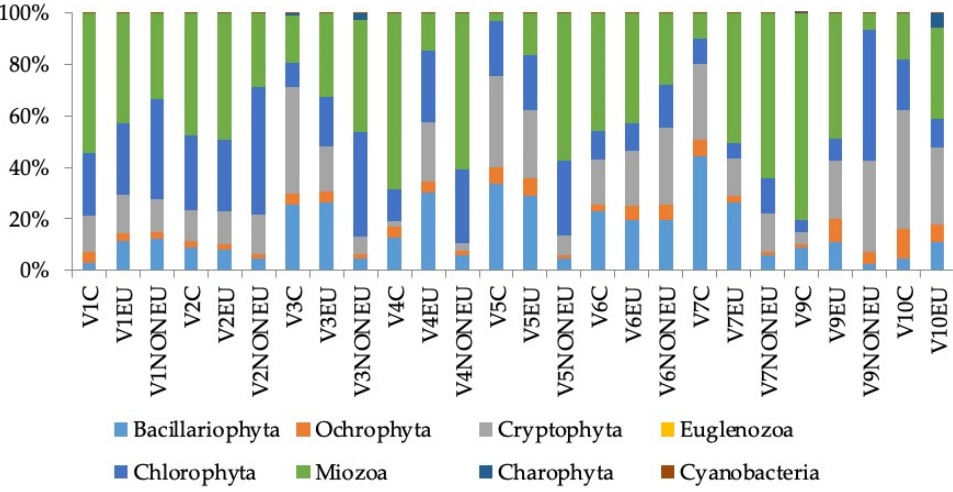
Figure 3. Relative biomass of phytoplankton taxonomic groups (expressed in percentages) in the composite (C), euphotic (EU) and aphotic (NONEU) zone samples from the sampling stations (V1 to V10, excluding station V8) in Lake Visovac during August 2018 according to the morphological approach.